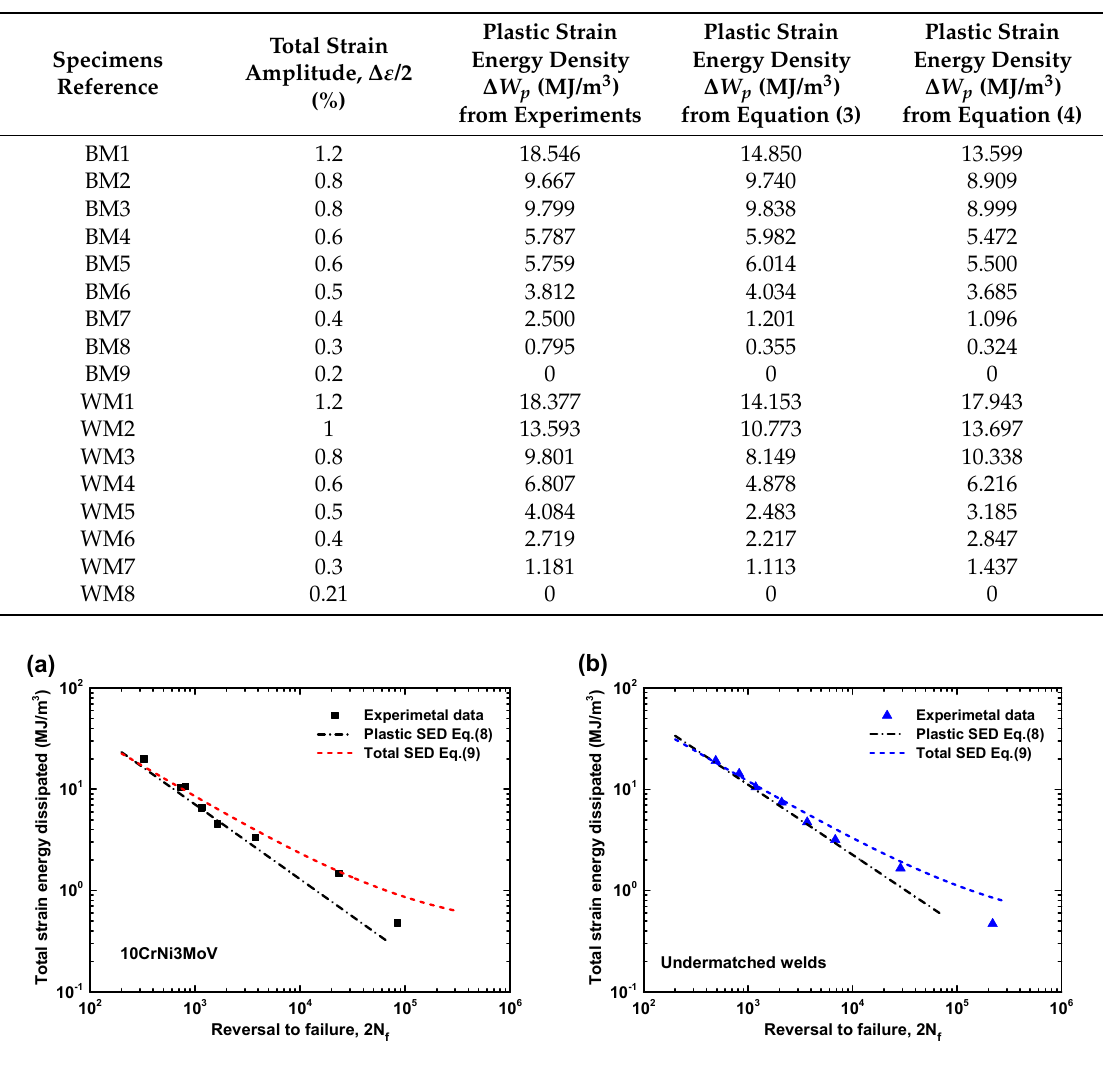
Figure 14. Comparison of total strain energy density ∆ W t from different equations: ( a ) 10CrNi3MoV high strength steel; ( b ) undermatched welds.